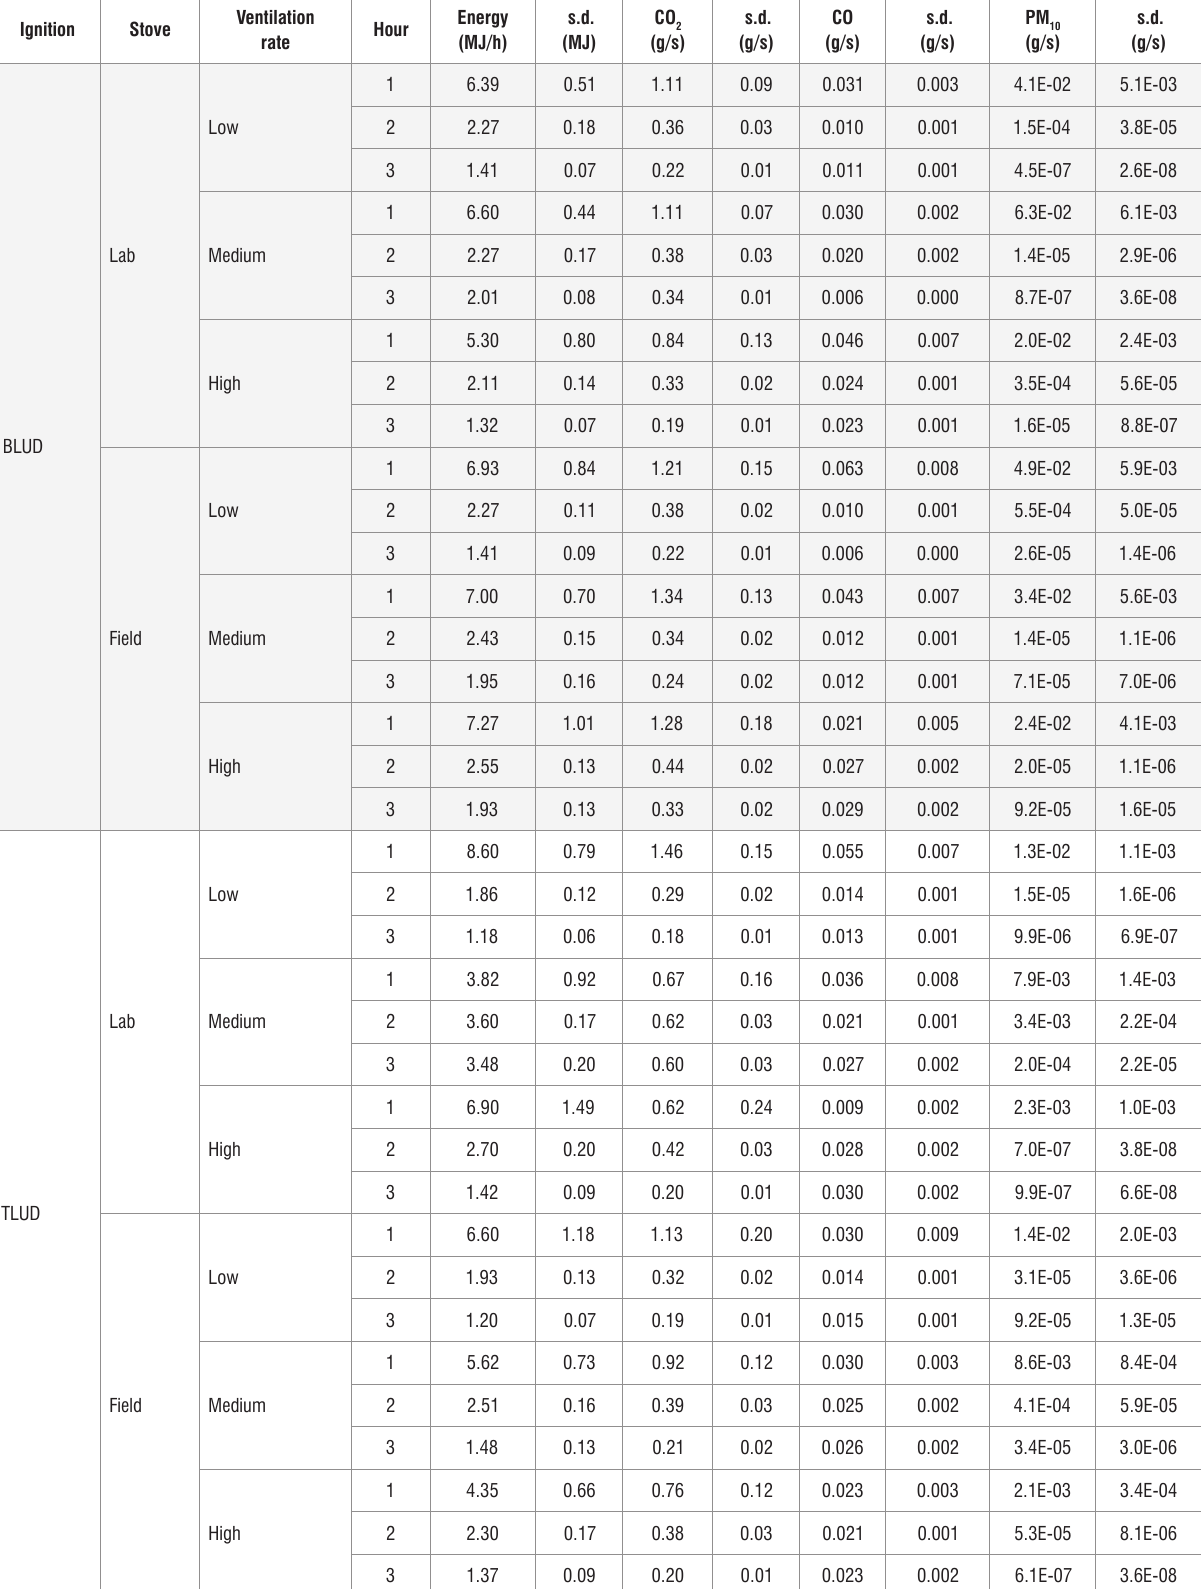
Table 6: Hourly average emission rates (g/s) during burn sequence (for dispersion modelling input) for lab and field stoves for the top-lit updraft (TLUD) and bottom-lit updraft (BLUD) ignition methods at low, medium and high ventilation rates ( n =5)